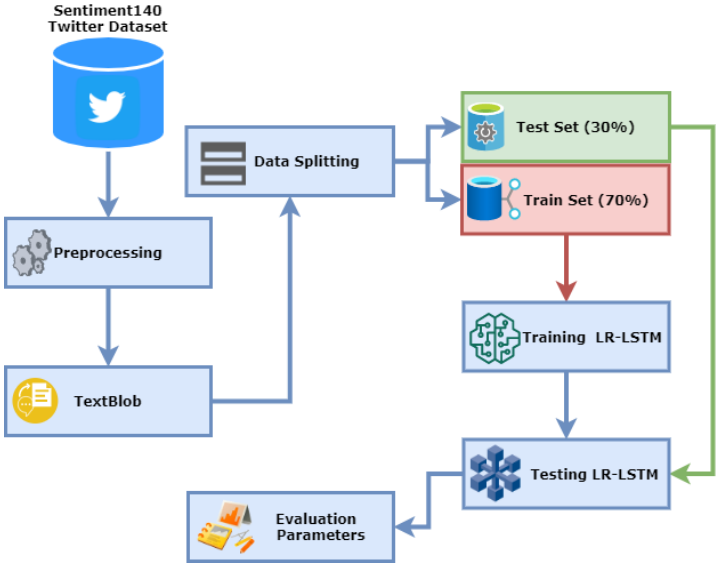
Figure 2. Architecture of the proposed